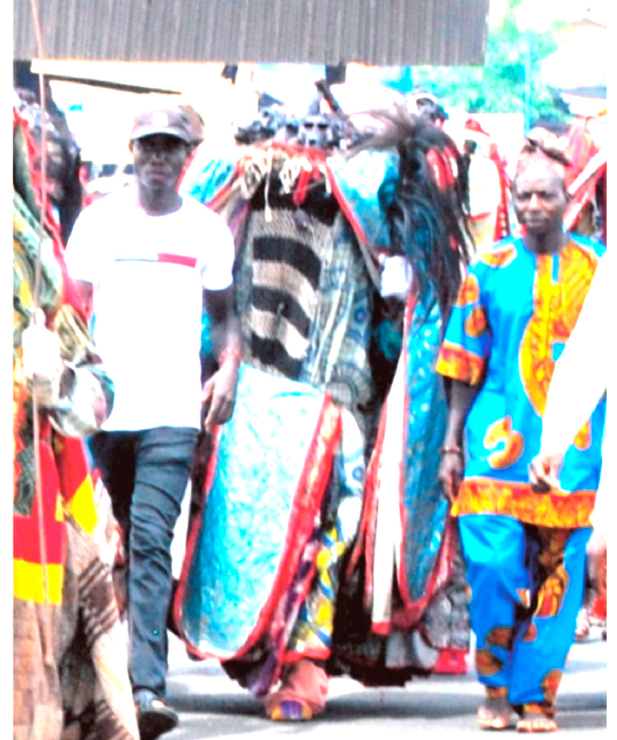
Figure 1. Egúngún Je ń jù during the 2018 annual egúngún festival, Òyó. Source: Photograph by author. Figure 1. Eg ú ng ú n Je´nj ù during the 2018 annual eg ú ng ú n festival, Ò y ó . Source: Photograph by